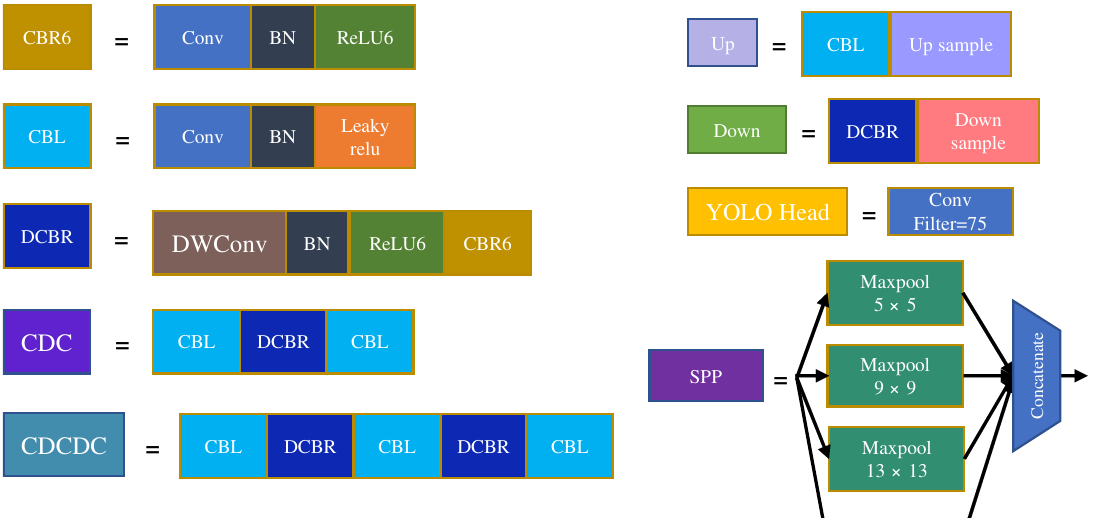
Figure 4. Detailed explanation of feature fusion and result prediction